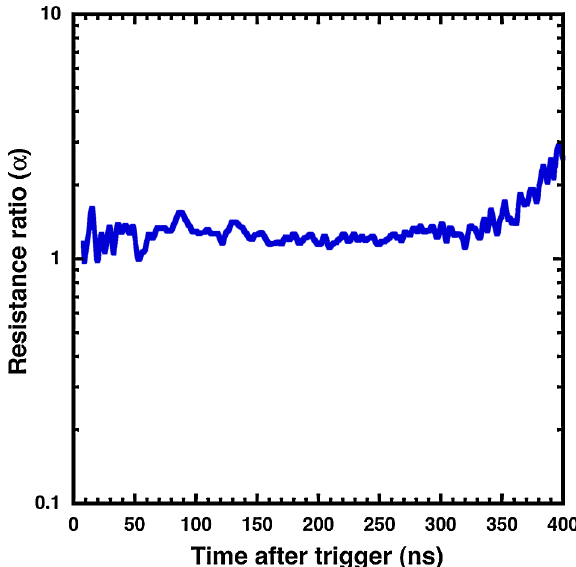
FIG. 12. (Color) Calculated resistance in normal mode with both sides conducting current, and with most of the current flowing on one side of the switch. Displacement current to the inactive side of the switch affects the calculated single channel resistance at 20